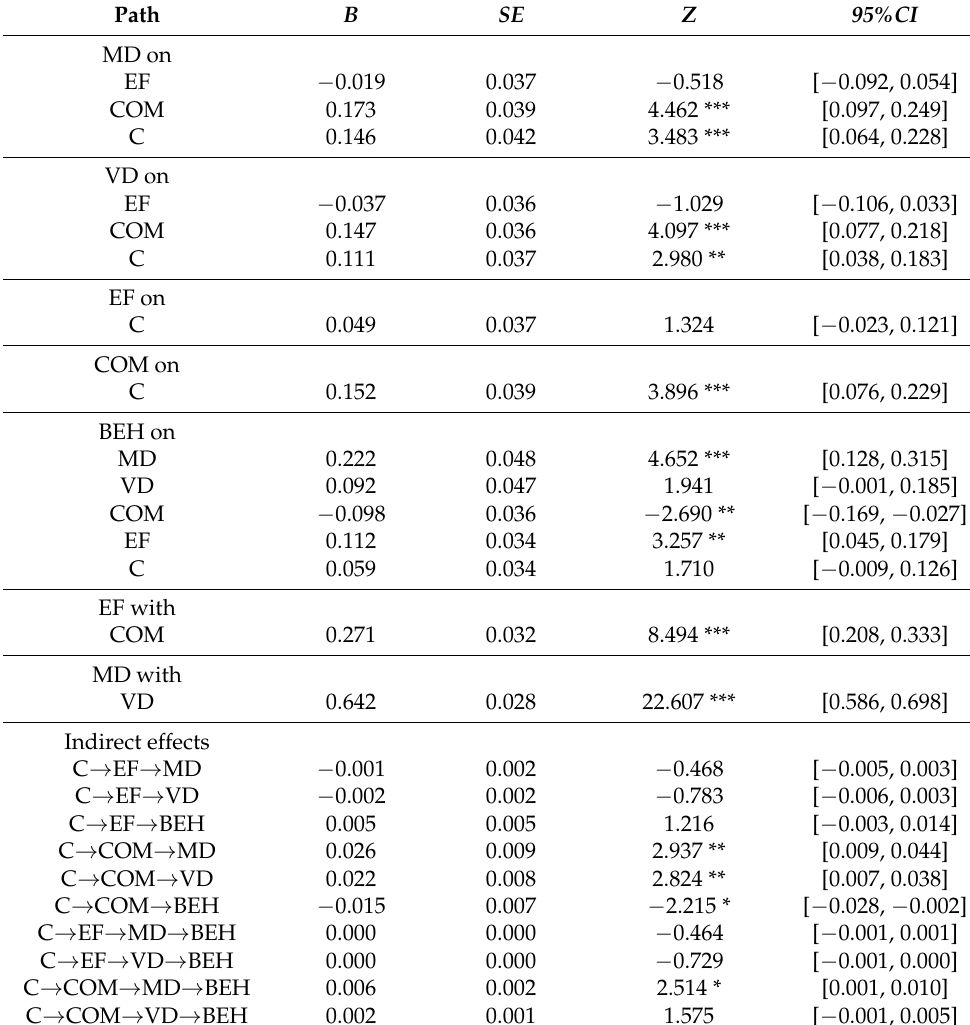
Table 3. Standardized estimates of the direct and indirect effects of the tested model ( n =